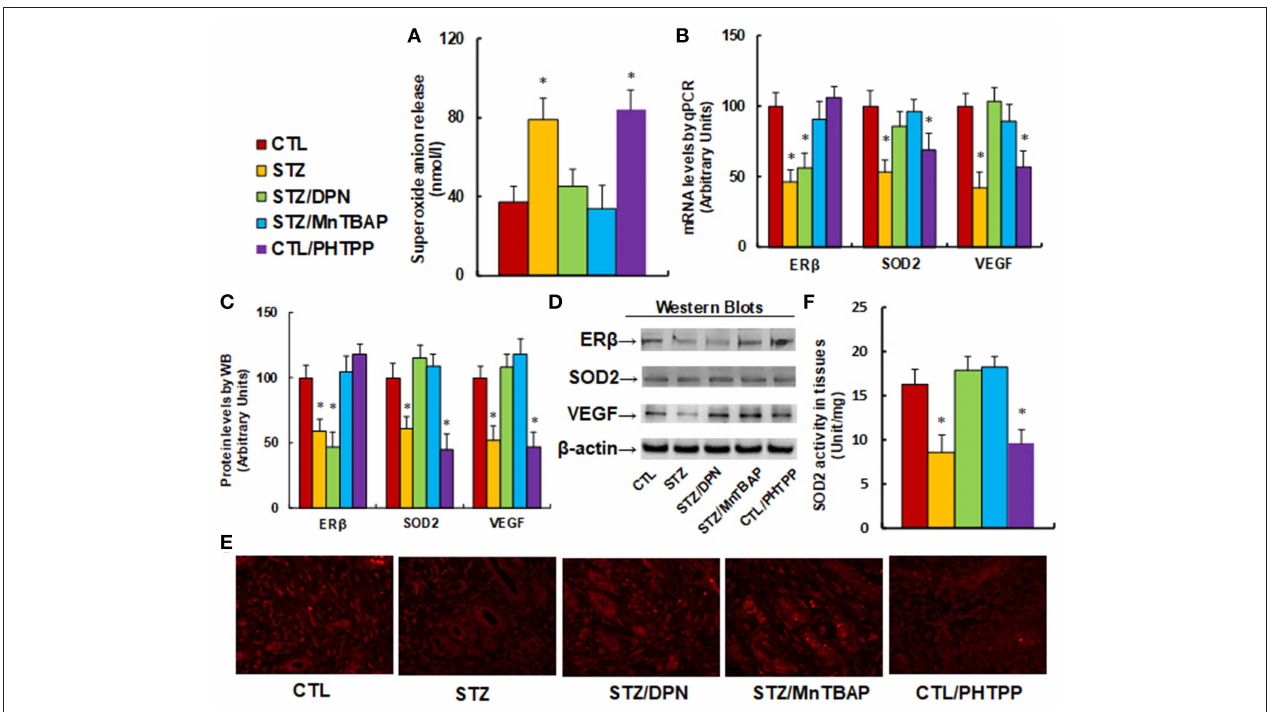
FIGURE 4 | ER β activation restores diabetes-induced persistent oxidative stress and VEGF suppression. The wounds were excised and collected from the experimental rats with either control rats (CTL), or STZ diabetic rats (STZ), or STZ rats treated by 450 µ g/kg/day of DPN (STZ/DPN), or STZ rats treated by 10 mg/kg/day of MnTBAP (STZ/MnTBAP), or CTL rats treated by 450 µ g/kg/day of PHTPP (CTL/PHTPP) for further analysis. (A) Superoxide anion release, n = 5. (B) mRNA levels by qPCR, n = 4. (C) Protein quantitation for western blots, n = 4. (D) Representative pictures for (C) . (E) Representative pictures for VEGF expression by immunohistochemistry. (F) SOD2 activity assay, n = 5. * P < 0.05, vs. CTL group. Data are expressed as mean ±